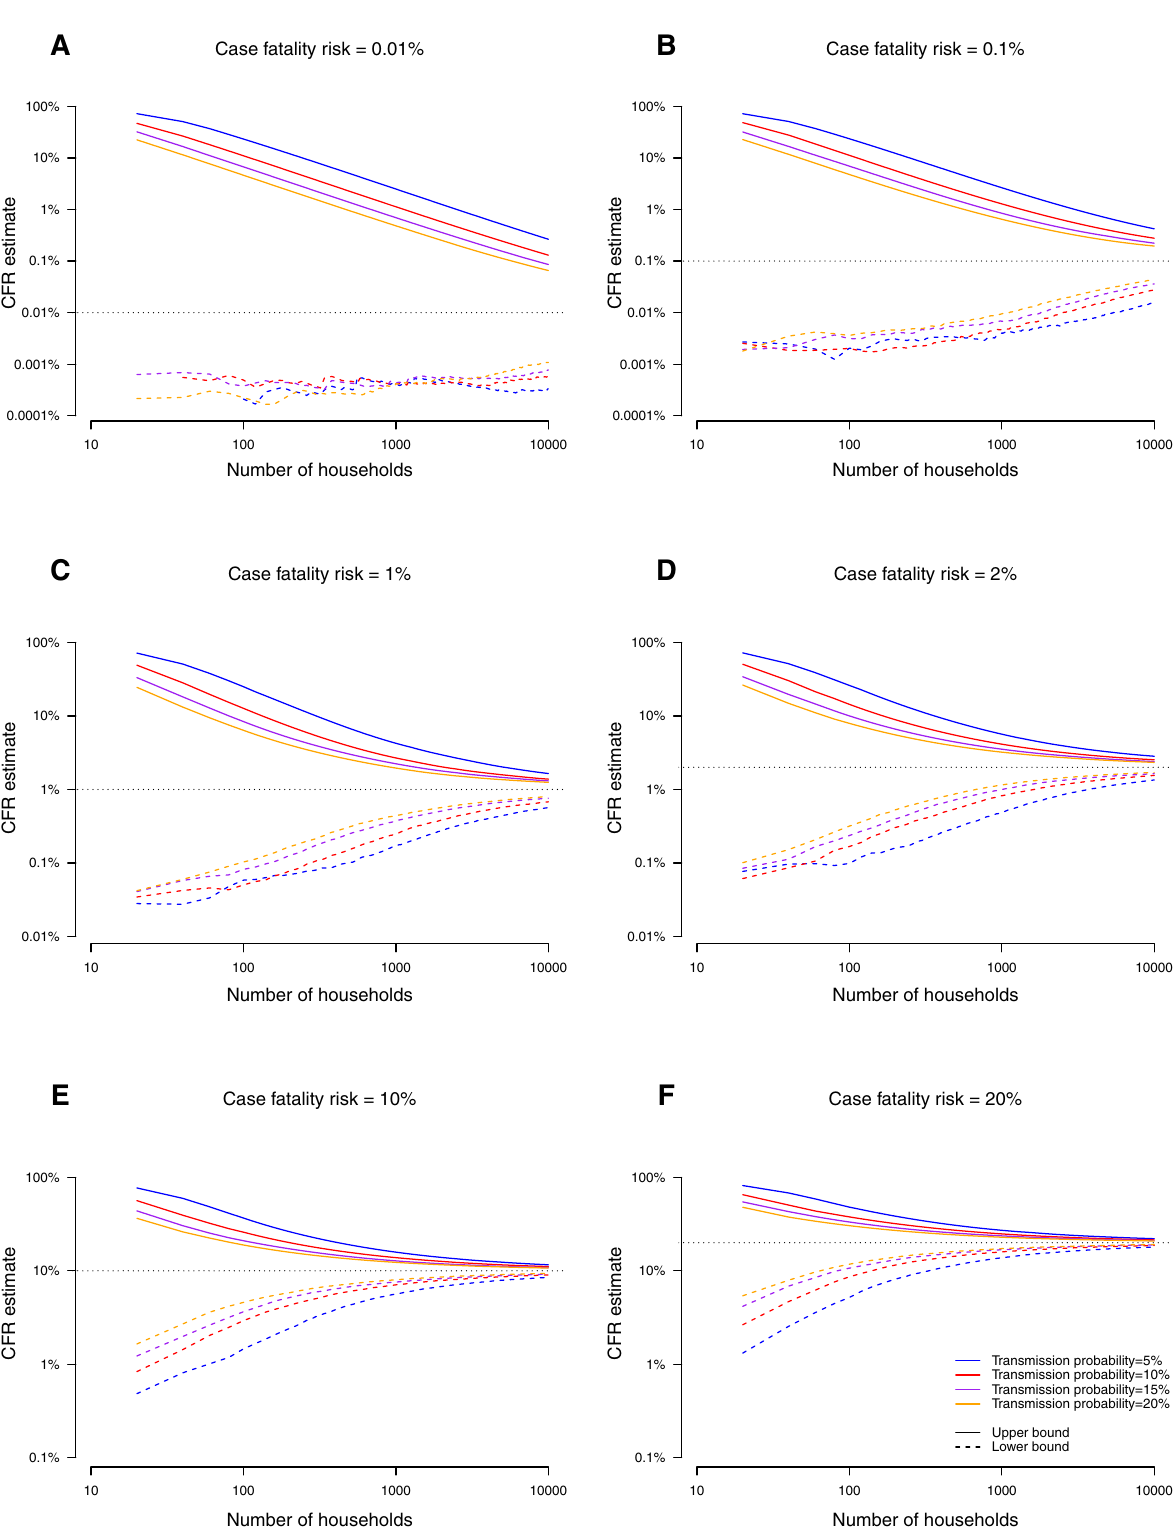
Fig. 6 The estimates of CFR and associated uncertainy with different number of households. The lower bound and upper bound of estimates for case fatality risk (CFR) under different value of CFR (Panel A-F), and different secondary infection risk in